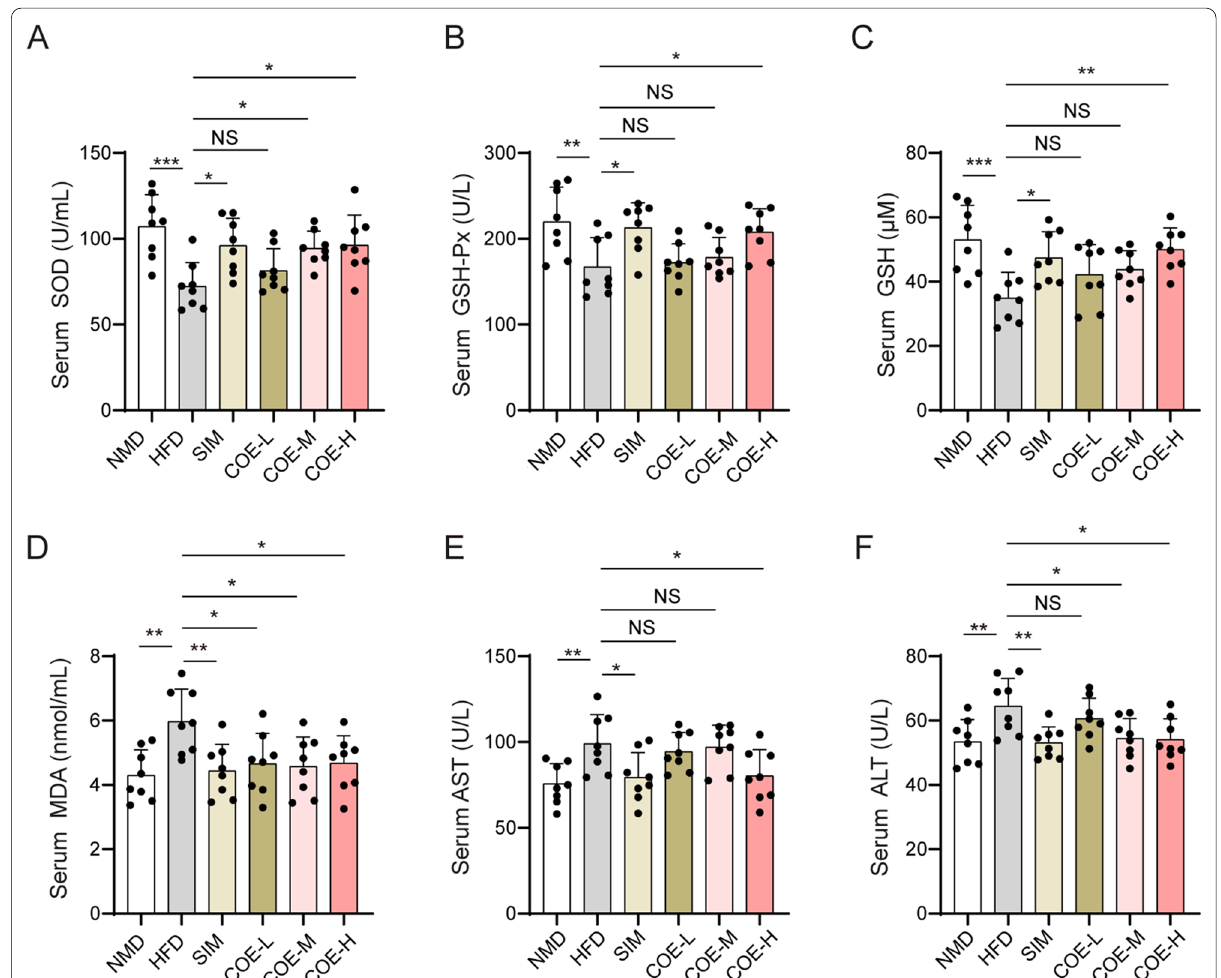
Fig. 4 Effects of COE on serum antioxidant enzyme activities and liver function. SOD ( A ), GSH-Px ( B ), GSH ( C ), MDA ( D ), AST ( E ), and ALT ( F ) levels were examined in the serum of hyperlipidemic rats treated with COE or SIM. n